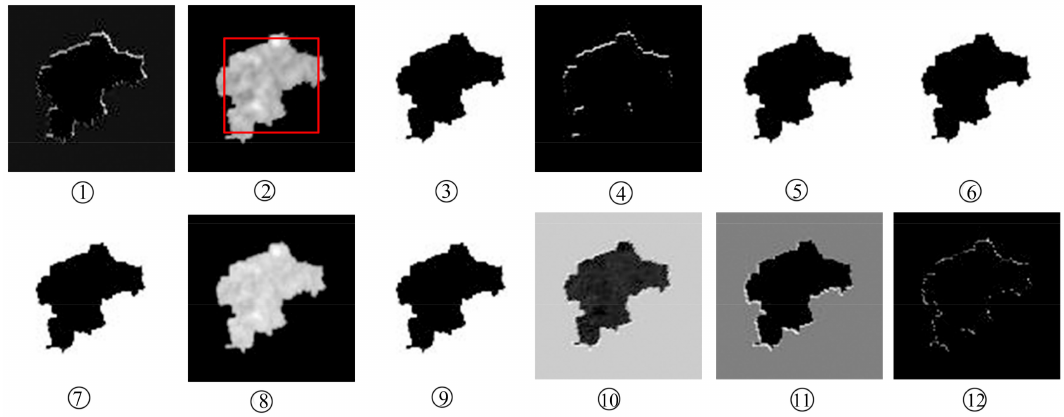
Figure 3. Example of feature maps (the red box in feature map 2 (cid:13) represents a central 53 × 53